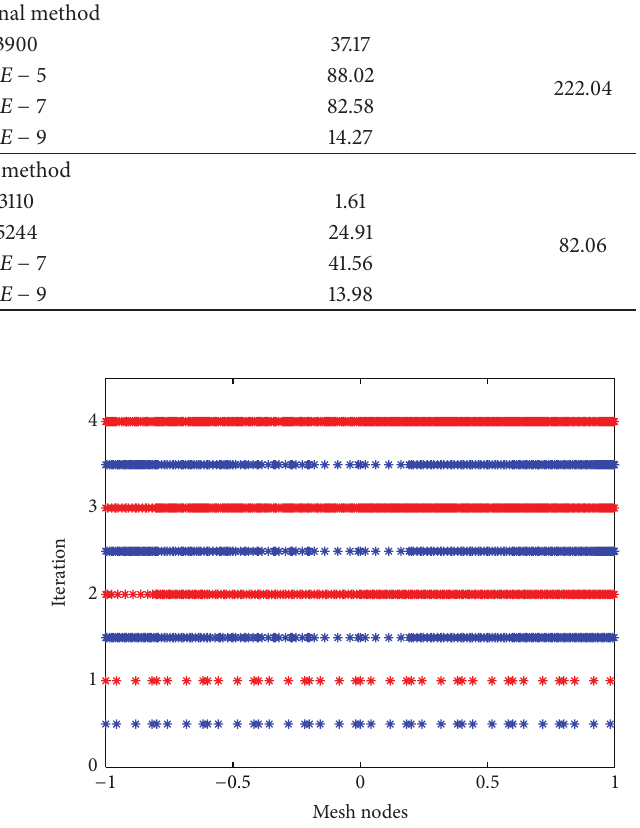
Figure 4: Distribution of mesh nodes (blue: new method, red: traditional